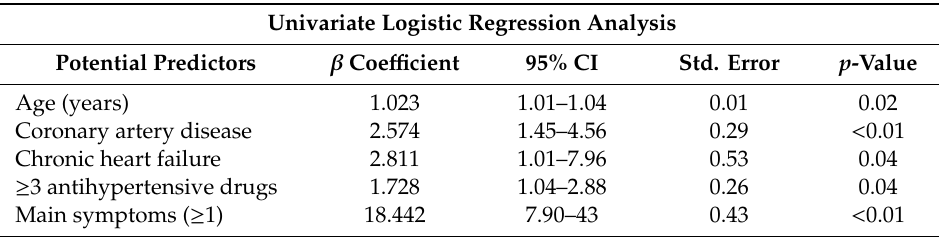
Table 4. Logistic regression analysis of potential